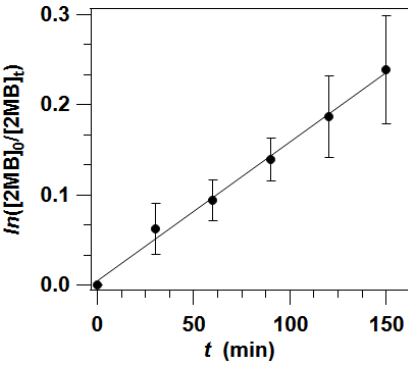
Figure 3. Plot of Eq. (1) in which the average ln([2MB] 0 / [2MB] t ) over time has been represented